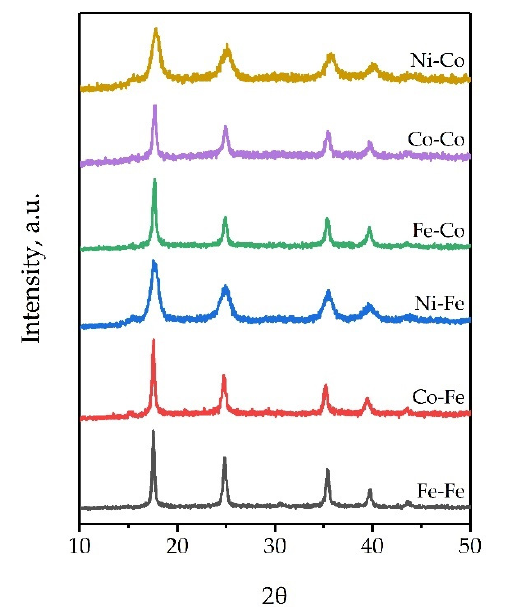
Figure 4. XRD spectra for the studied porous hexacyanometallates(III).